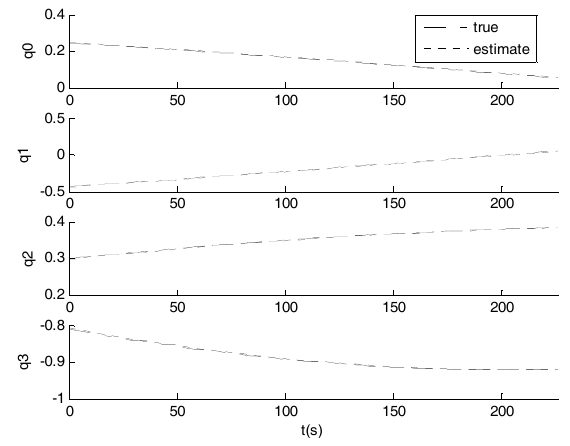
Figure 14. Attitude estimation results of a night sky experiment.